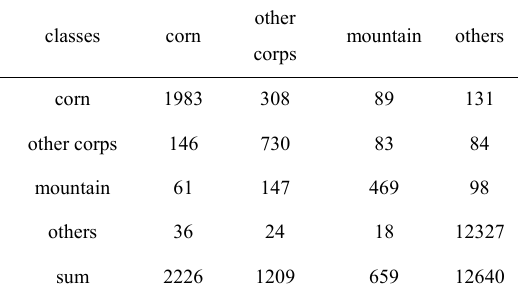
Table 2. Classification by single TM